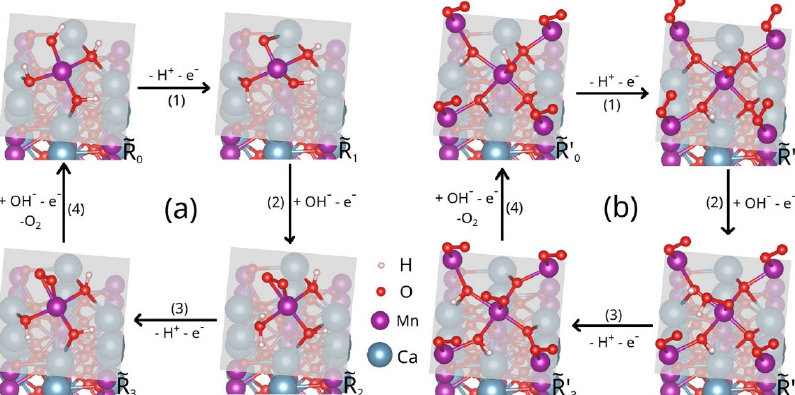
Figure 19. ( a ) OER cycle on surface Mn 2 O 4 − 1.0Mn − 1.0O. ( b ) OER cycle on surface Mn 2 O 4 + 2.0O. Surfaces are named with the format “termination ± #atom”, where + and − represent adatoms and vacancies, respectively, and # represents the number of atoms introduced/removed per supercell relative to a reference surface with fixed termination, which can be either Mn 2 O 4 or Ca 2 O 2 . (Reprinted from ref. [140] with permission from ACS Catalysis. Copyright © 2018, American Chemical Society). Du et al. [141] have shown that non-stoichiometric CaMnO 3−δ (δ ≈ 0.25) with moderate oxygen-defects improves the electrical conductivity and hence the OER activity. Density